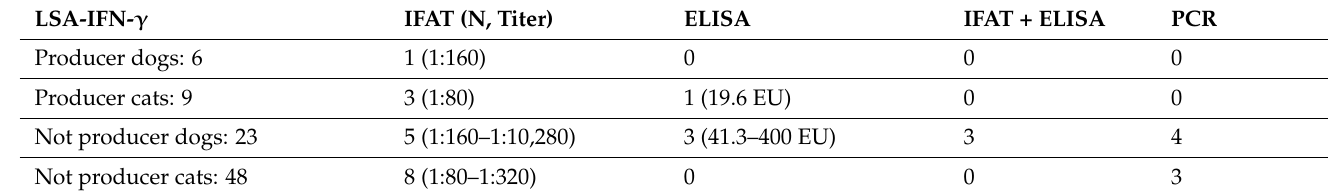
Table 3. Description of the number of IFN- γ producer and not producer dogs and cats positive at IFAT, ELISA, IFAT + ELISA or PCR with description of the IFAT titers and ELISA units